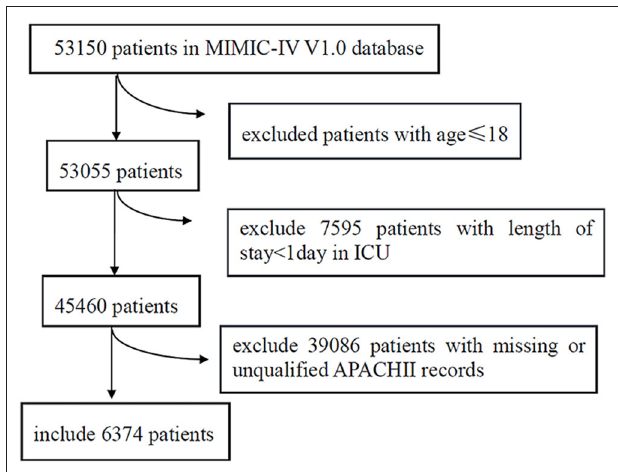
FIGURE 1 | Flow chart of selecting patients according to the inclusion and exclusion